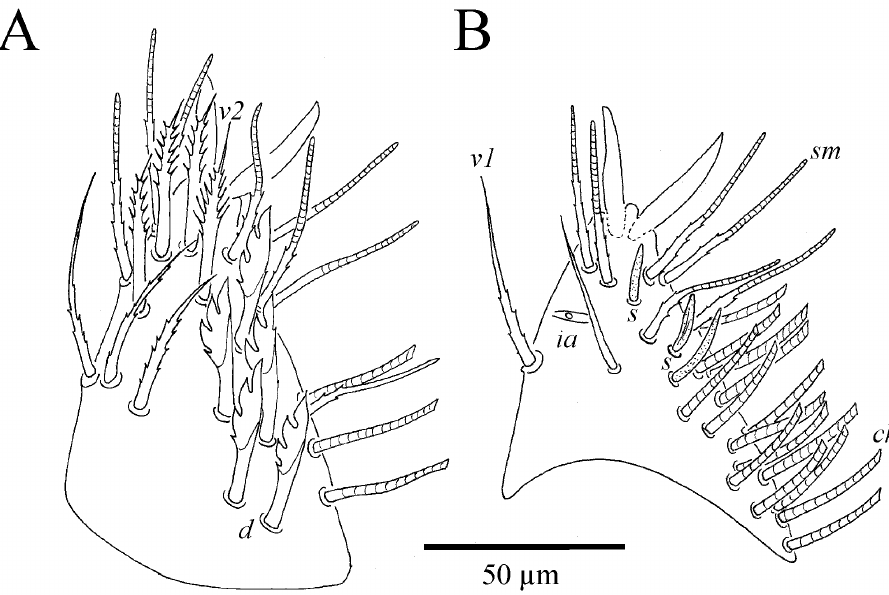
Figure 3. Neocarus spelaion sp. n.: Ventral ( A ) and dorsal ( B ) view of the palp tarsus.